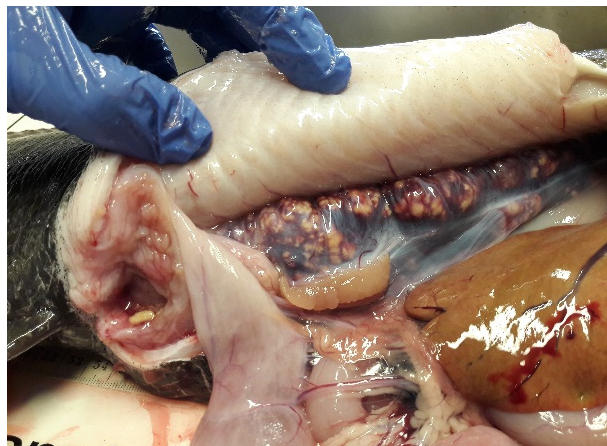
Figure 3. Extreme example of nephrocalcinosis with calcareous deposition all along the kidneys of a mature farmed-origin male sacrificed in 2018 at Nord University (Bodo, Norway). Source (J. Beirão).